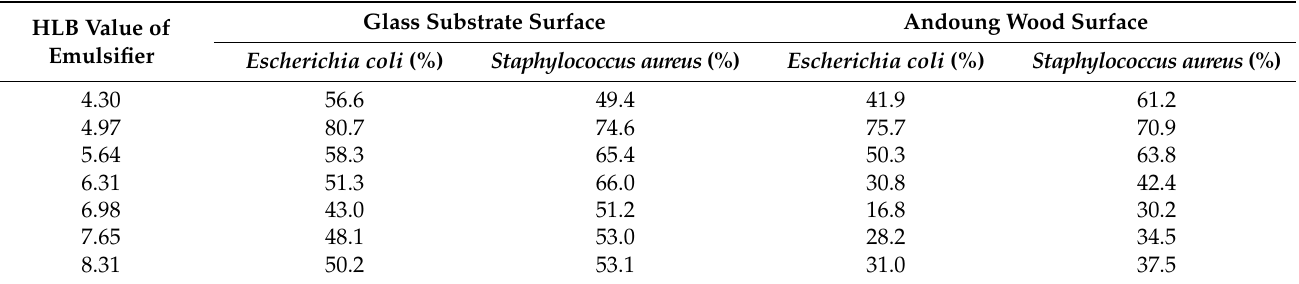
Table 10. Antibacterial rate of Escherichia coli and Staphylococcus aureus on different substrates for waterborne primer